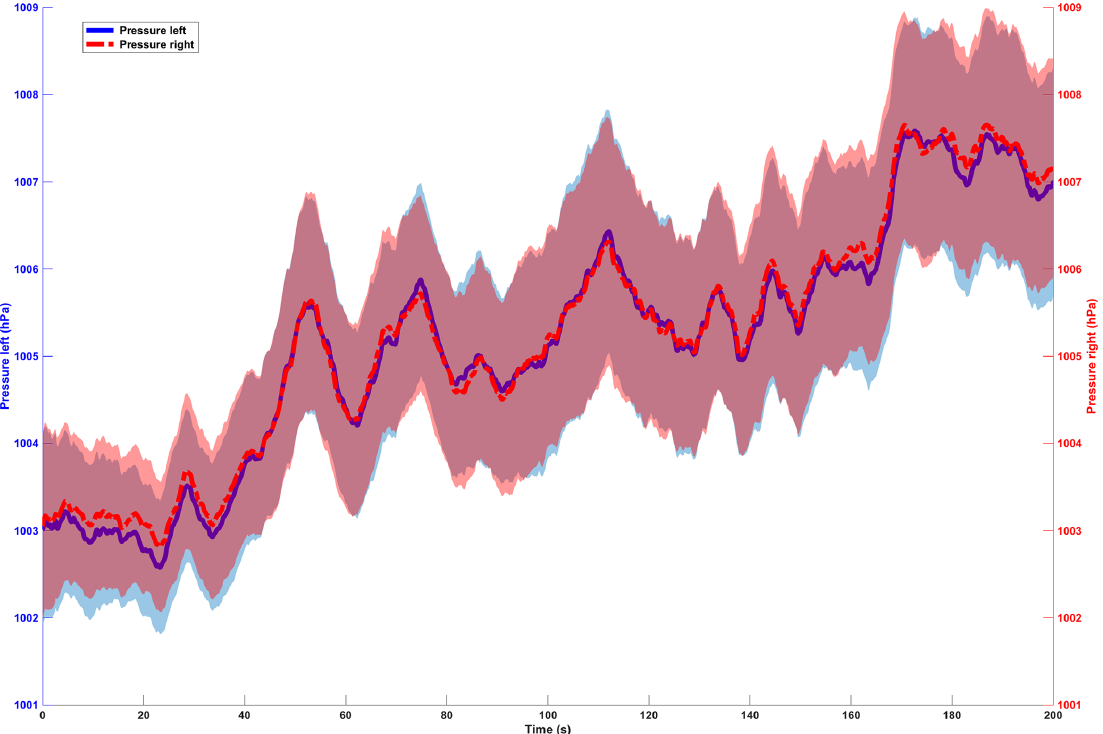
Figure 5. Mean values and 95% CI (shaded area) of the left and right pressure over 40 deployments ( n = 40) over the first 200s of the flow path passage. The data are averaged over a 5s time window and across 40